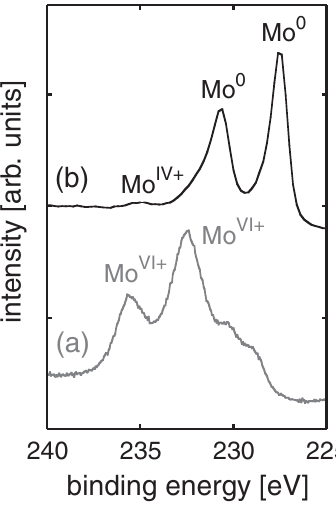
FIG. 10. Mo 3 d multiplet photoemission spectra measured on: (a) untreated Mo; (b) Mo heated at 875 (cid:1) C in UHV, transferred to the XPS system after a 30 min air exposure. The spectra are vertically shifted for